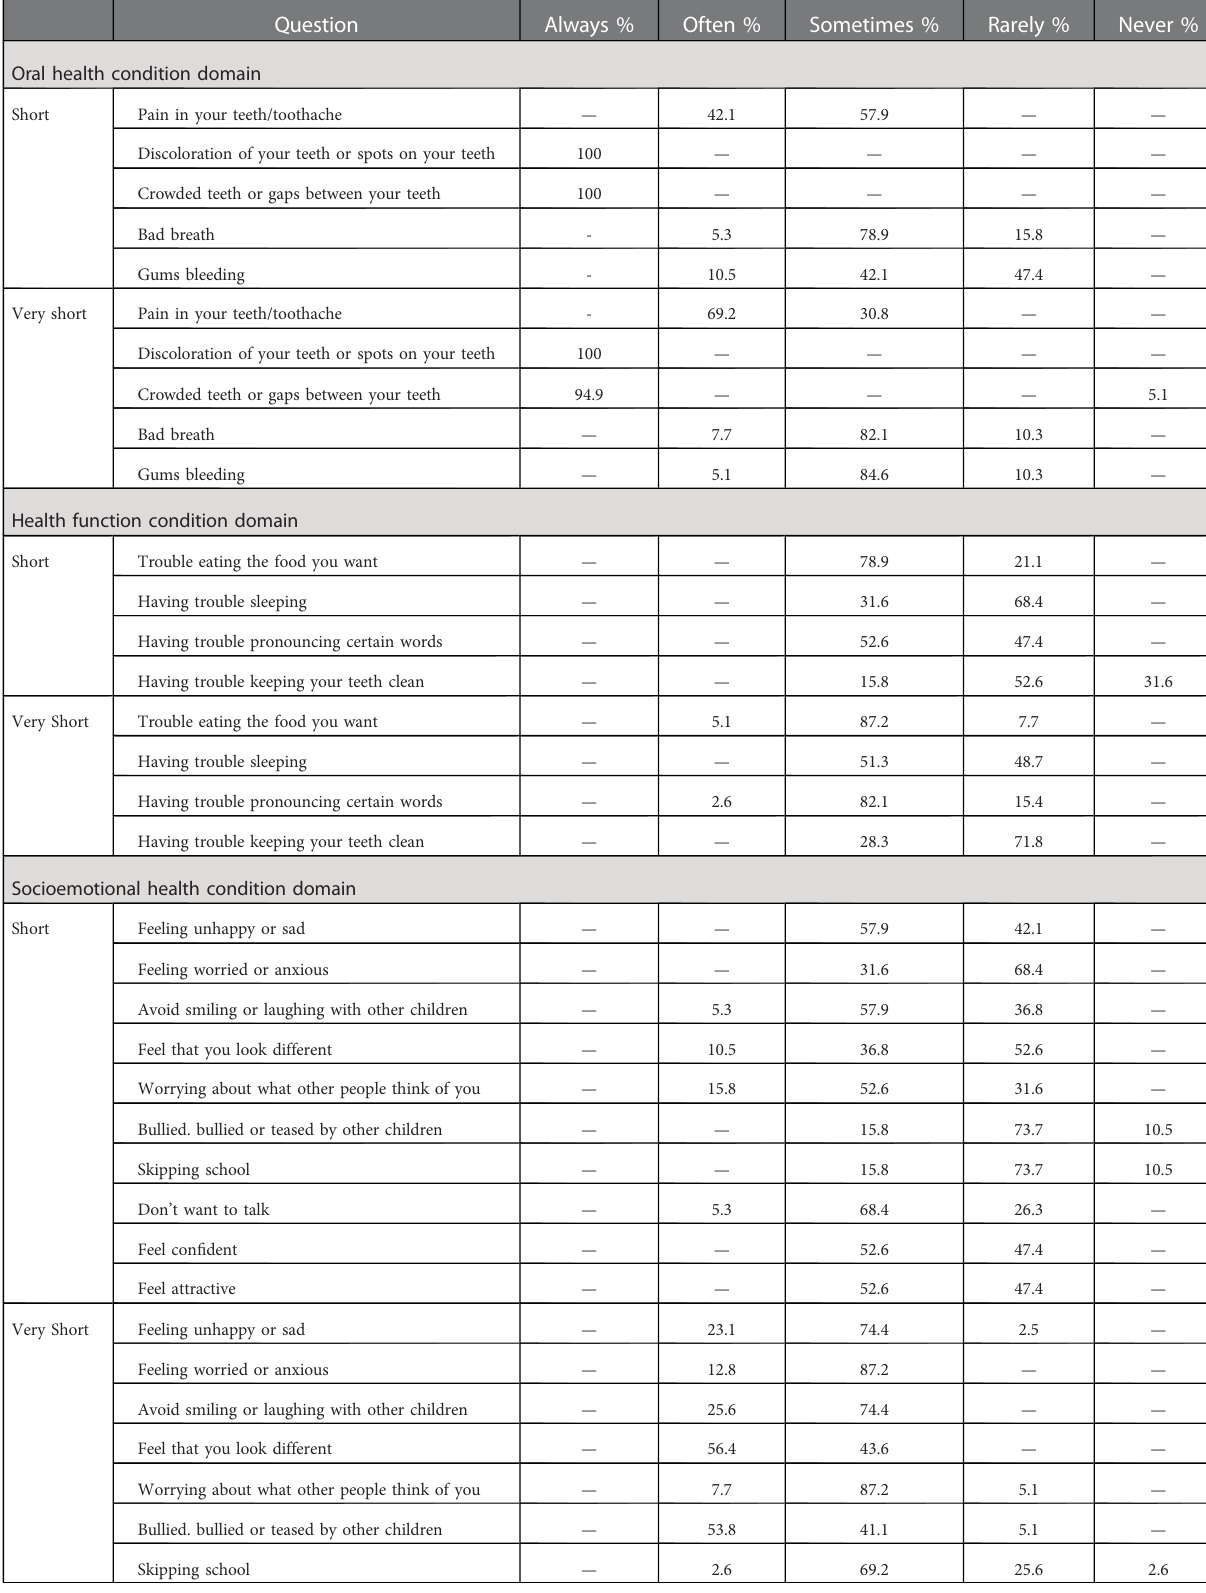
TABLE 3 Oral Health-Related Quality of Life. Question Always % Often % Sometimes % Rarely